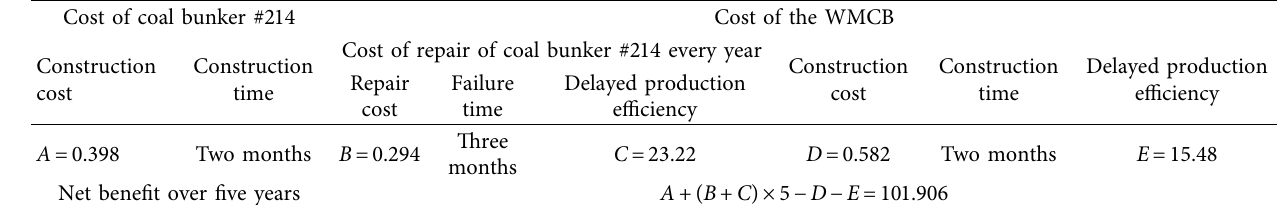
Figure 18: Monitoring of bunker fall and diameter convergence. Table 5: Calculation of the economic benefits (unit: million